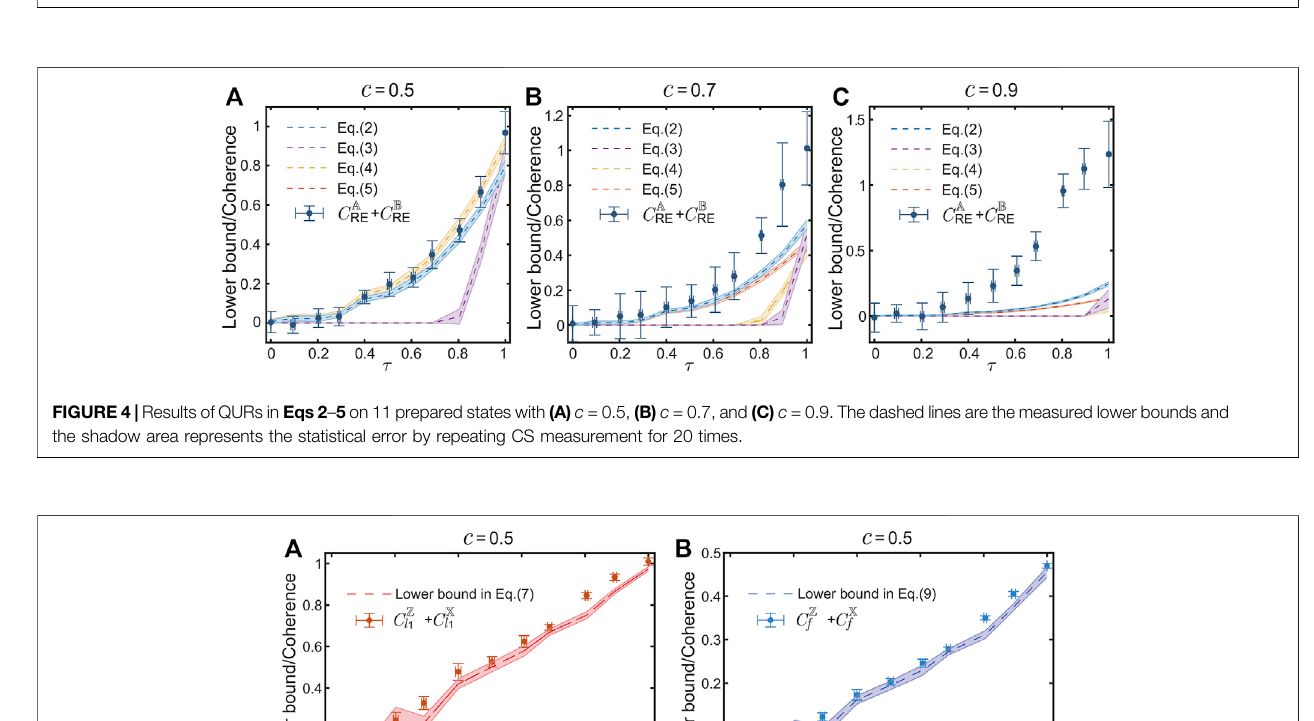
FIGURE 3 | Results of estimated lower bounds in Eqs 2 – 5 with different c on state (A) ρ ( τ = 1), (B) ρ ( τ = 0.894), (C) ρ ( τ = 0.688), and (D) ρ ( τ = 0.291), respectively.